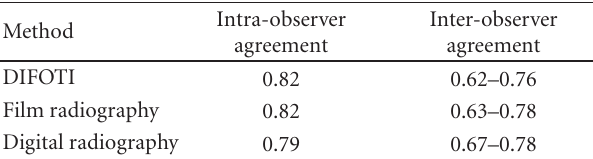
Table 1: Reproducibility of the three diagnostic methods, in form of intra-examiner agreement presented as mean κ w , and inter- examiner agreement presented as range of mean κ w based on results from the eight observers. Intra-observer Method